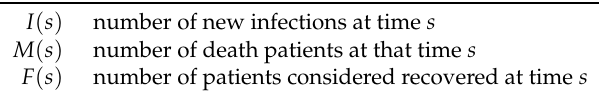
Table 1. Main variables used in the